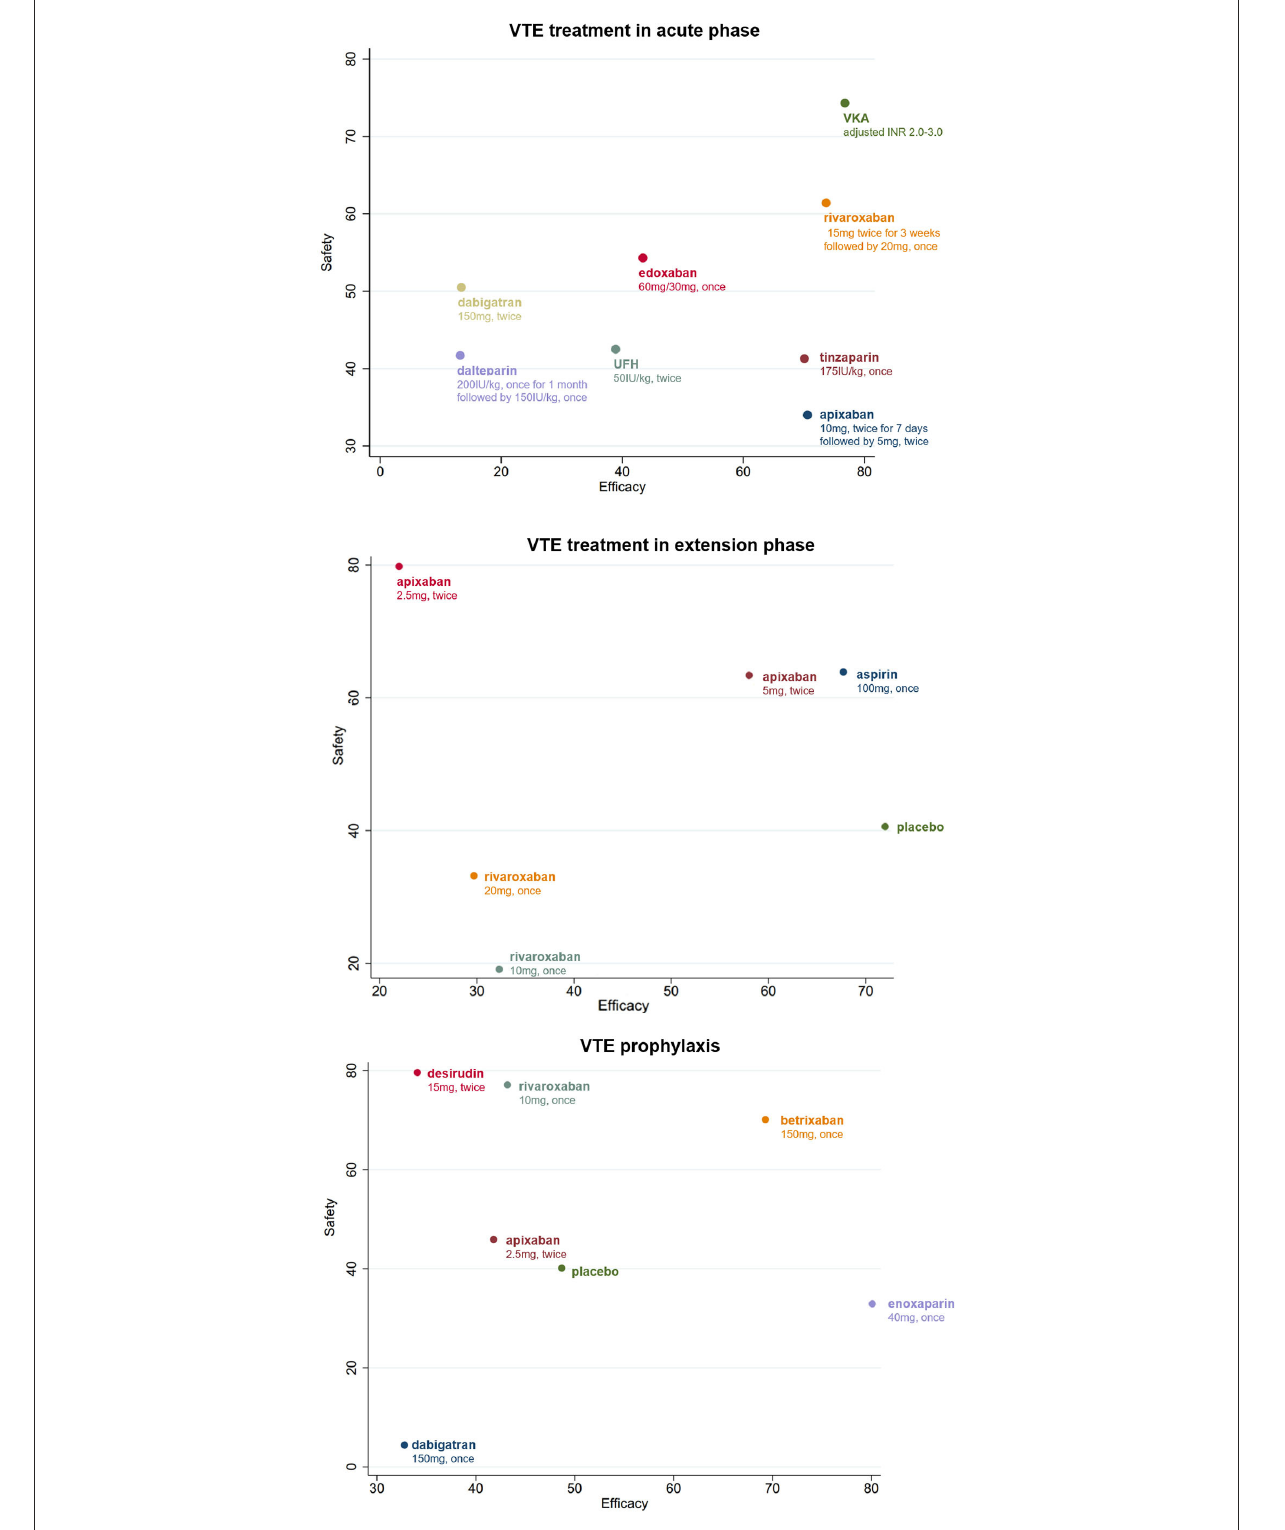
FIGURE4 Clustered ranking plot of the different treatments based on cluster analysis for efficacy and safety for VTE patients with renal insufficiency. All drugs are present as daily dose and frequency. VTE, venous thrombus embolism; VKA, vitamin K